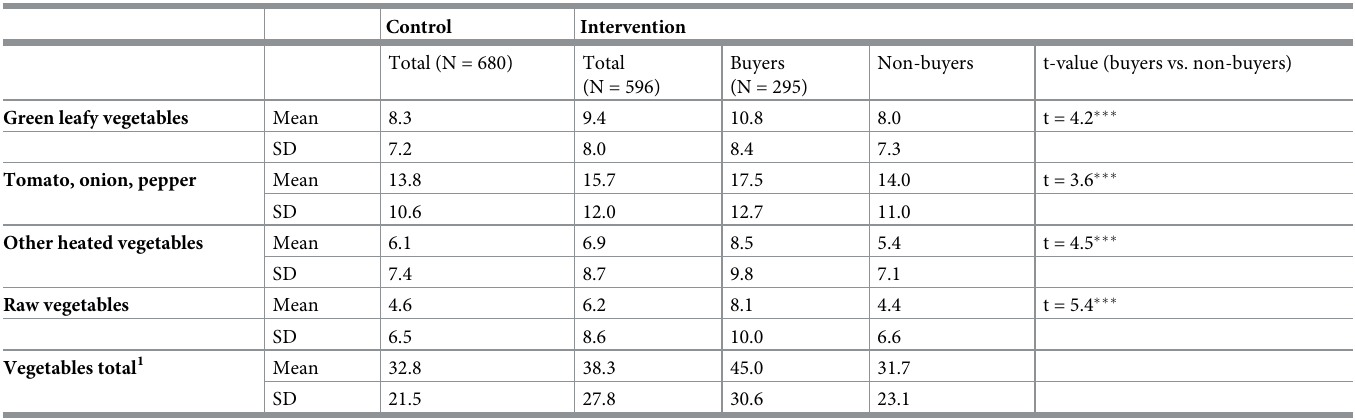
Table 4. Mean values of self-reported vegetable consumption at FUTA and Secretariats during control and intervention